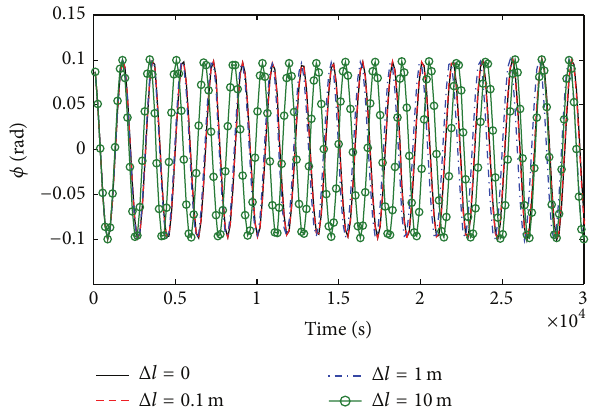
Figure 20: The time history of yaw angle 𝜙 with different Δ𝑙 , 𝜏 = 0 .